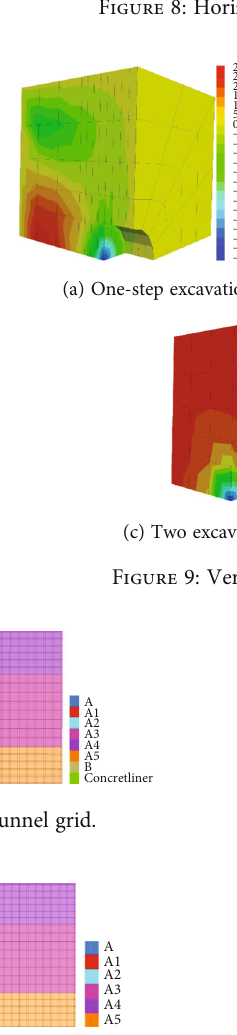
Figure 8: Horizontal displacement cloud map.